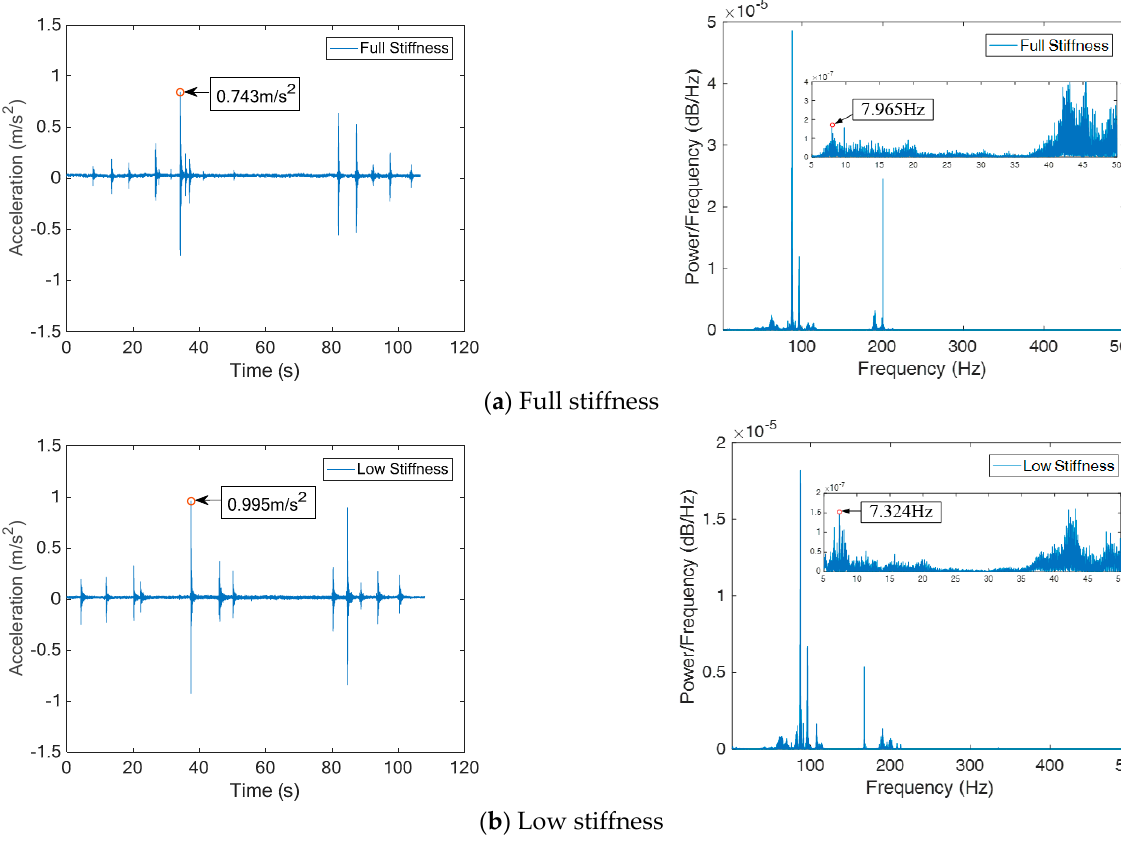
Figure 13. Effect of stiffness on the vertical acceleration of the bridge. The effect of bridge stiffness on the vertical acceleration of suspension bogie is shown in Figure 14. The maximum vertical acceleration of full stiffness and low stiffness were 7.493 m/s 2 and 14.413 m/s 2 , respectively, which is obviously larger than the vibration amplitude of the bridge. It indicates that the vibration acceleration of suspension bogie increased by 6.92 m/s 2 when the bridge height was reduced by 20 cm, and in the 40–60 s stage when the train was suspending, the vibration with low stiffness was significantly greater than that of the full stiffness. It can be seen from the spectrum diagram that the frequency band distribution in the range of 400 Hz was wider, and it had more high- frequency components than the bridge vibration spectrum, which could be regarded as the interference vibration caused by the complex components inside suspension bogie and the connected carriage. The first-order vibration frequency was 4.62 Hz at full stiffness and 5.24 Hz at low stiffness. It reflects that the first-order vibration frequency is independent of external load or stiffness, only related to the structure, size, and material of the suspension bogie. In addition, the power frequency signal (50 Hz and its multiple fre- quency) generated by electromagnetic interference had higher energy.